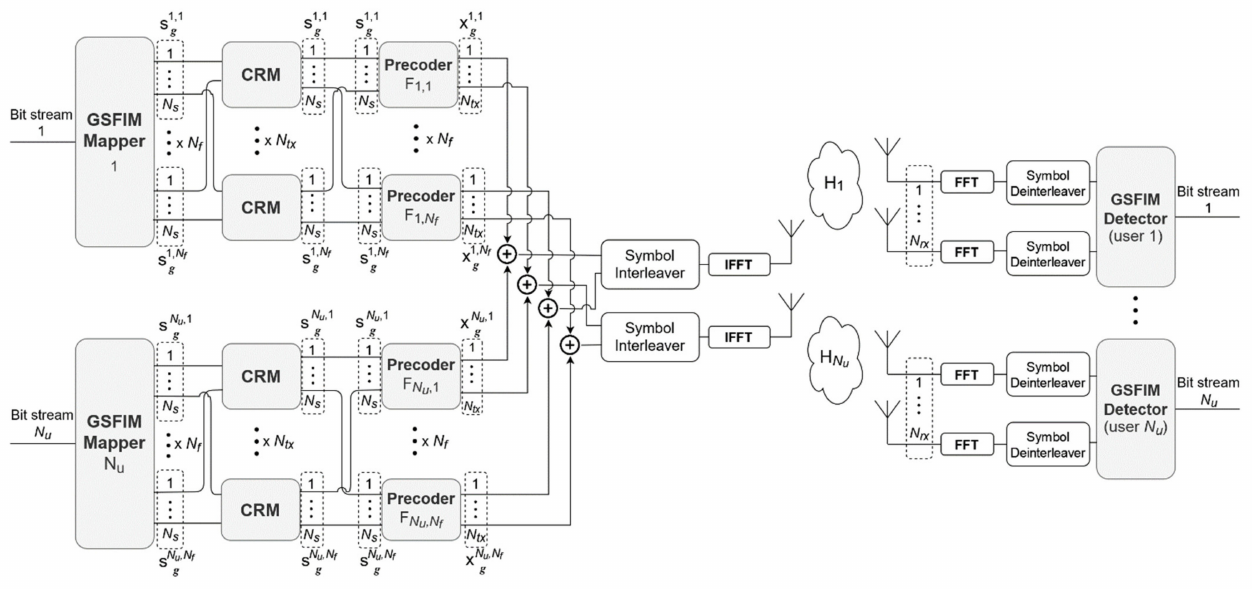
Figure 1. Transmitter and receiver structure